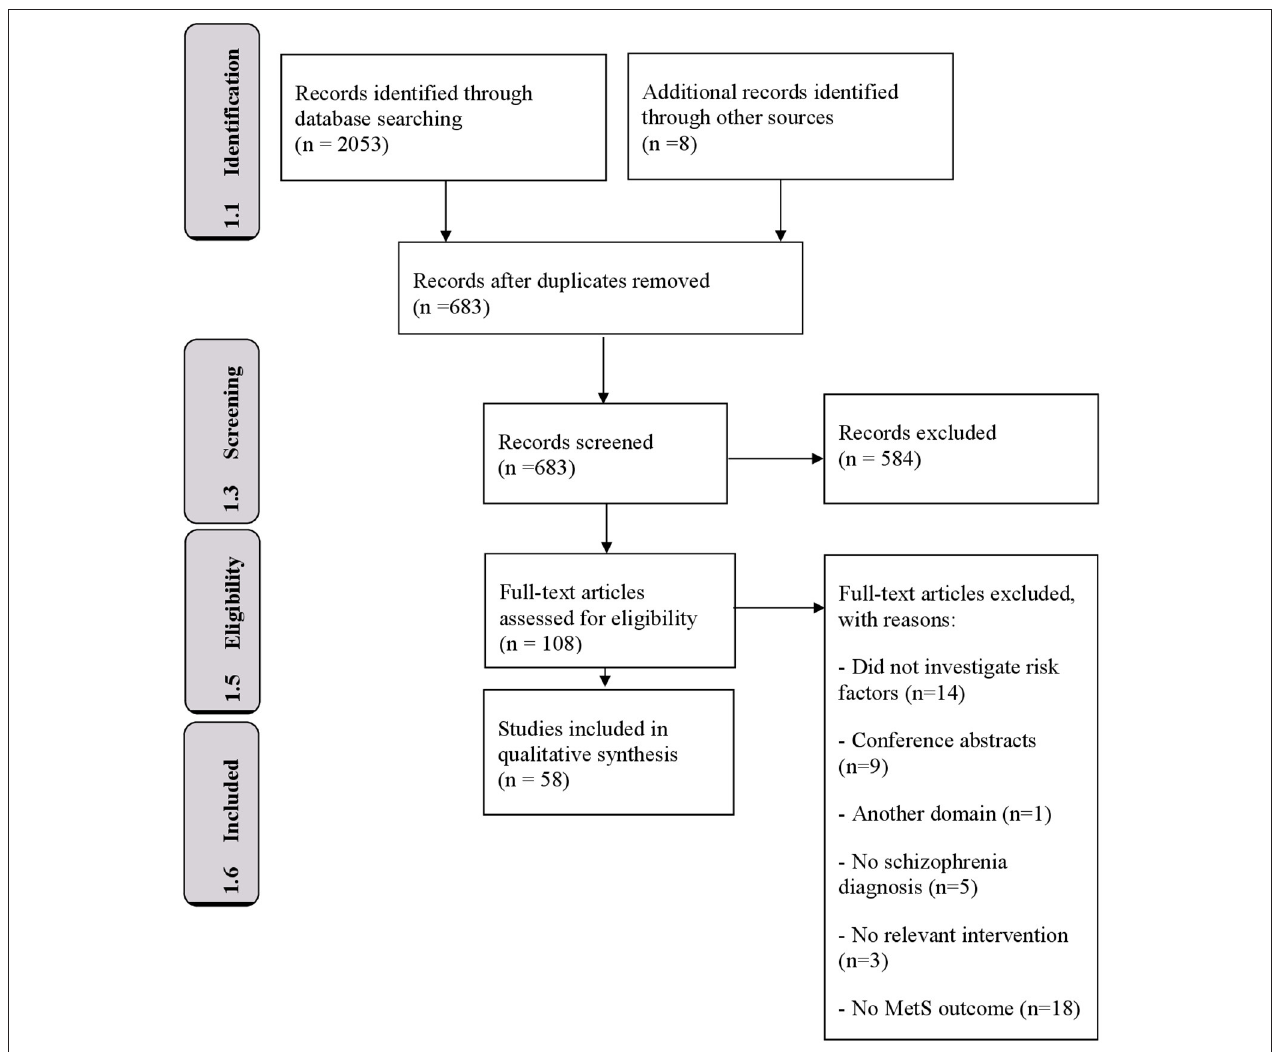
FIGURE 1 | Flow diagram of the review selection